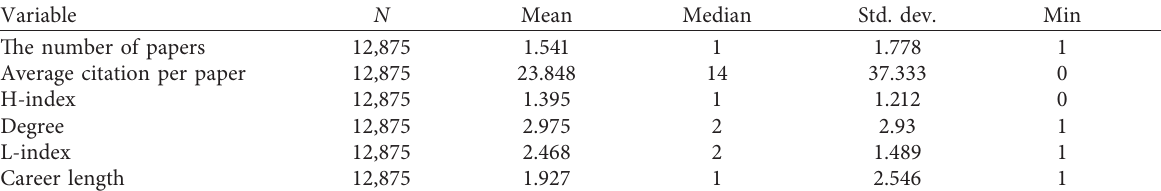
Table 1: The descriptive statistics of independent and dependent variables.